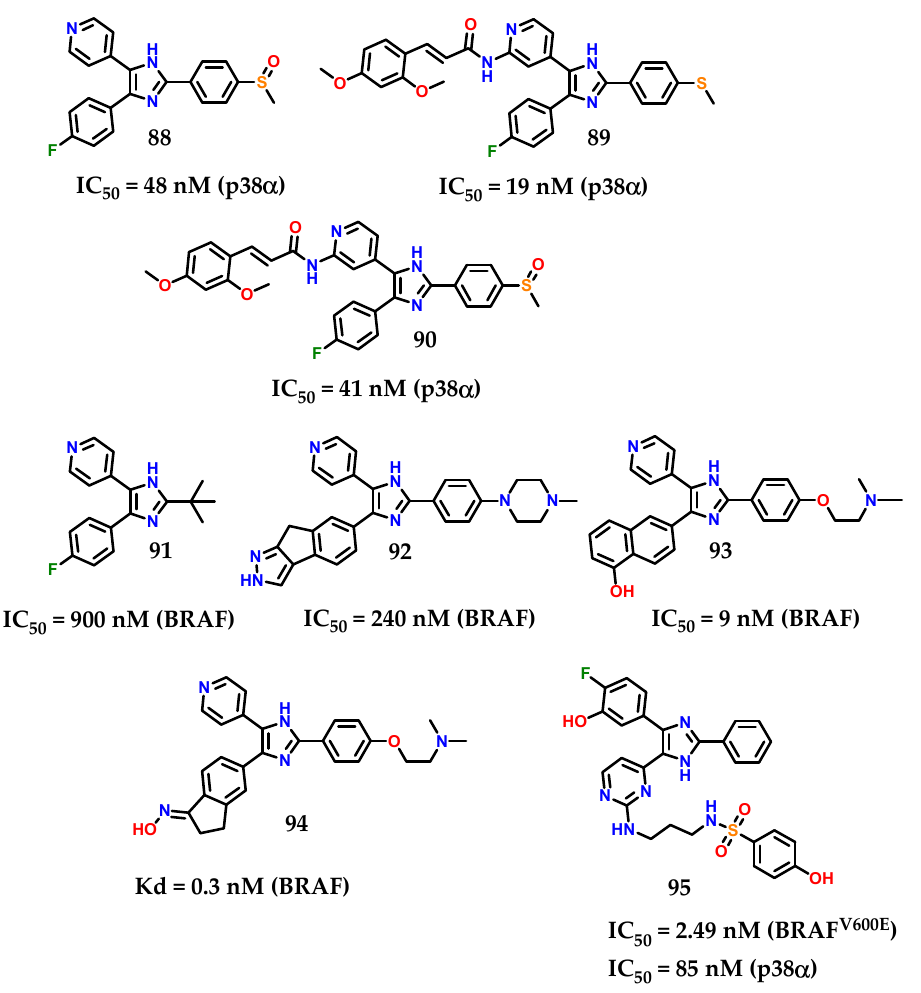
Figure 36. Di/triaryl imidazole-based derivatives with p38α and/or BRAF inhibitory